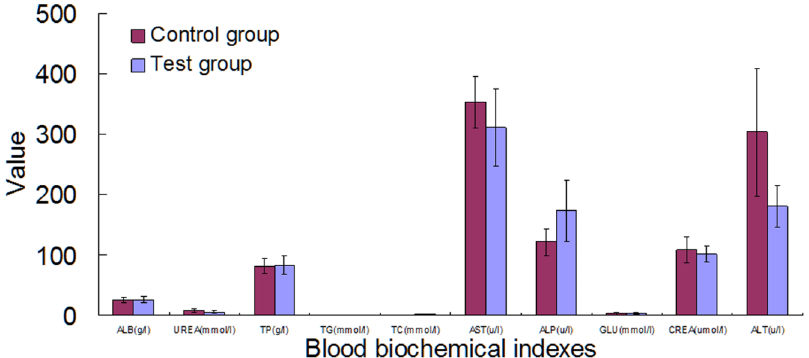
Figure 4. Effect of Cry1Ab protein on the blood biochemistry in Swiss rat that feeding for 90 days. The blood biochemistry indexes including ALB, UREA, TP, TG, TC, AST, ALP, GLU, CREA and ALT were assayed. The red bar represents the control group and the blue bar represents the test group.